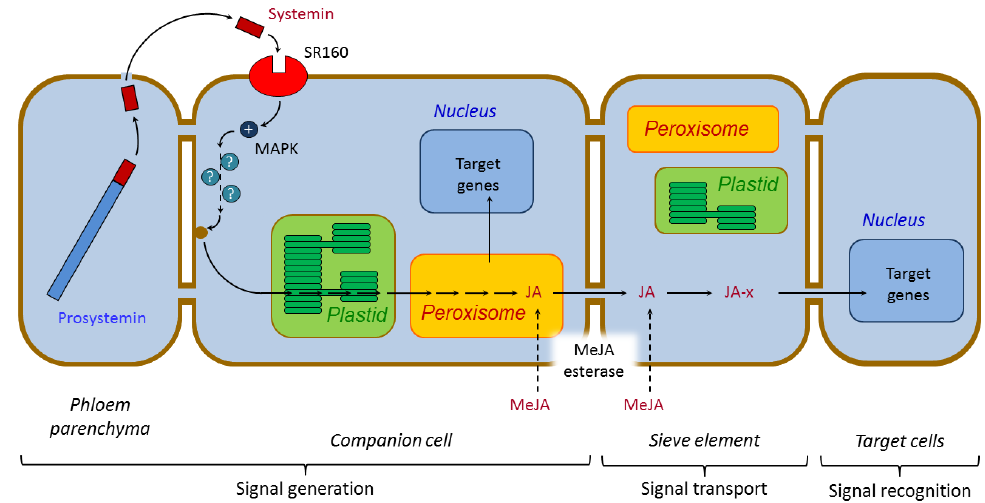
Figure 4. Model of systemic signaling and activation of defense genes in response to wounding by insect attack. After wounding, the systemin peptide is released from the C -terminal end of its precursor prosystemin by proteolytic processing. Systemin then enters the apoplast, where it binds to a membrane-bound receptor (SR160) to initiate an intracellular signaling cascade. The cascade includes the activities of a MAP kinase (MAPK), and a couple of unknown intermediates, leading to the release of polyunsaturated fatty acids (PUFAs) by phospholipases, from the membranes. The biosynthesis of JA takes place in the chloroplast and peroxisome within the companion cell, after which it might be transported long distances via the phloem. Plasmodesmatal connections between different cell types are shown as brown pipes. JA or a covalently modified form of JA (JA-x; such as JA-Ile) activates target gene expression in distal undamaged leaves. Esterases may convert exogenous MeJA to JA upon diffusion of MeJA across membranes. For simplicity, cell types presumed to be involved in phloem unloading of the signal are not shown. Mobile signals are shown in red and nonmobile signals in blue. Putative steps are denoted with dashed arrows (Adapted from